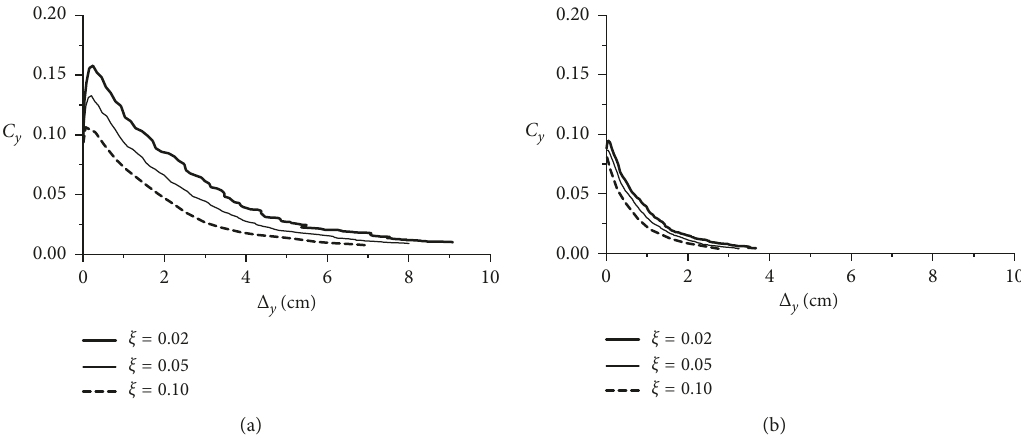
Figure 7: Effects of damping ratios on YPS for soil site B considering two ductility factors: (a) μ � 2; (b) μ �